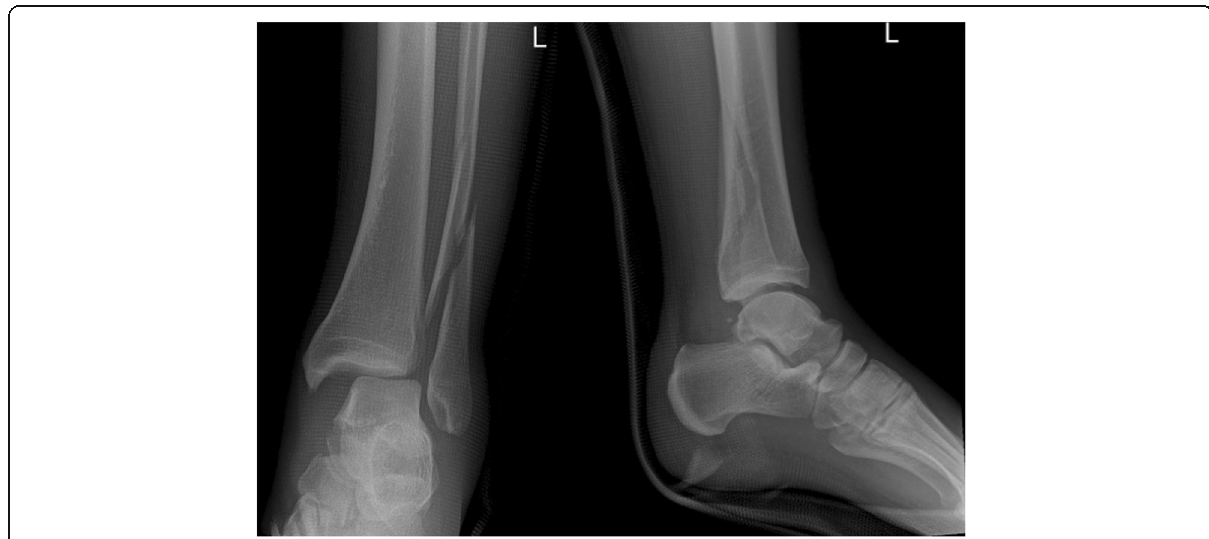
Fig. 1 Anteroposterior and lateral plain ankle radiographs of the initial injury showing a Weber C ankle fracture subluxation with widened medial clear space, increased tibiofibular clear space, decreased tibiofibular overlap and lateral subluxation of the